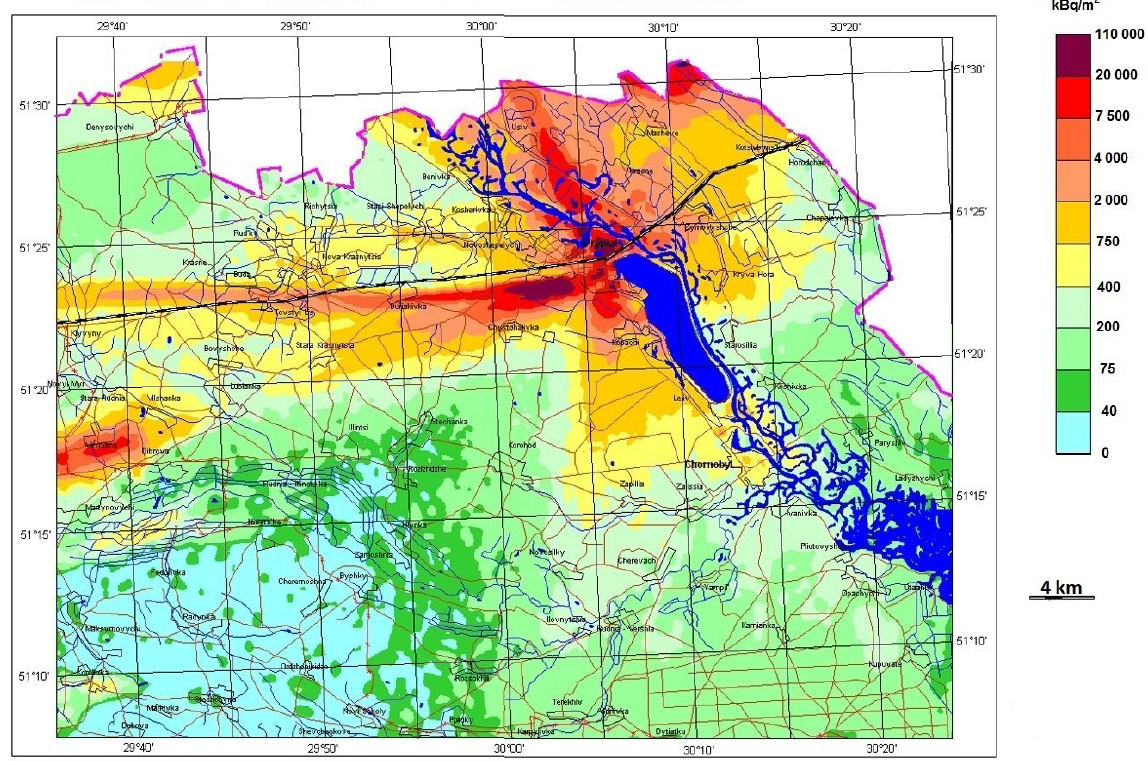
Figure 1. Caesium-137 deposition in the Ukrainian 30km exclusion zone estimated for 1997 (from UIAR, 1998).